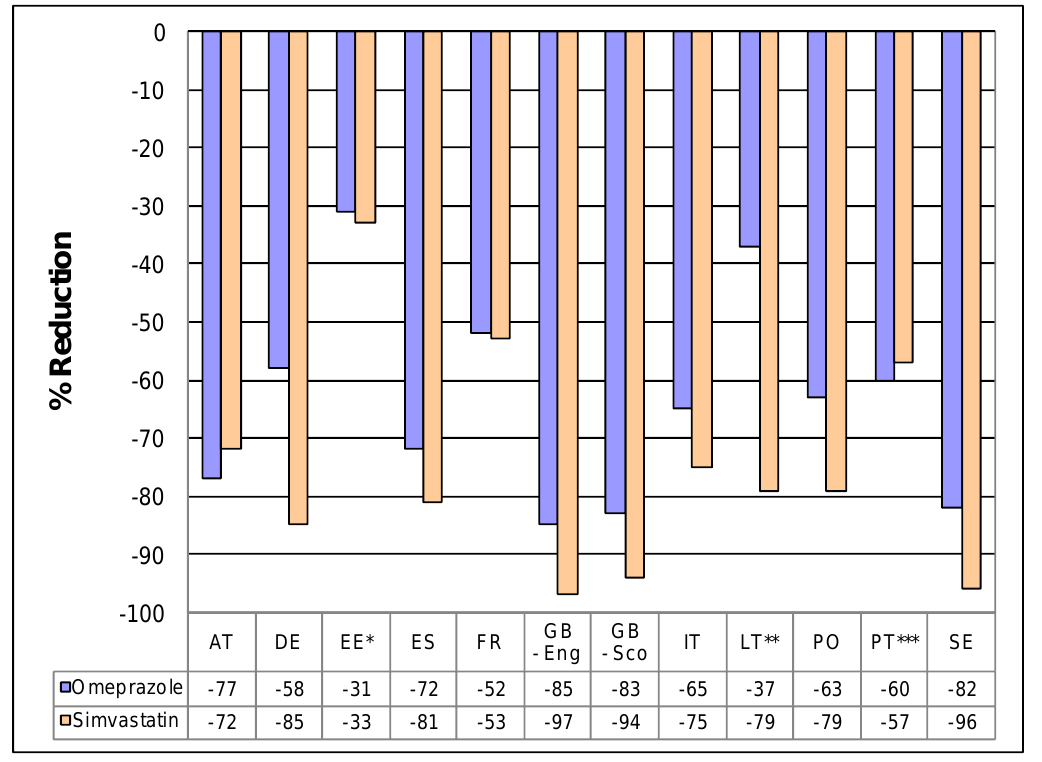
Figure 1. Percentage reduction in reimbursed expenditure for generic omeprazole